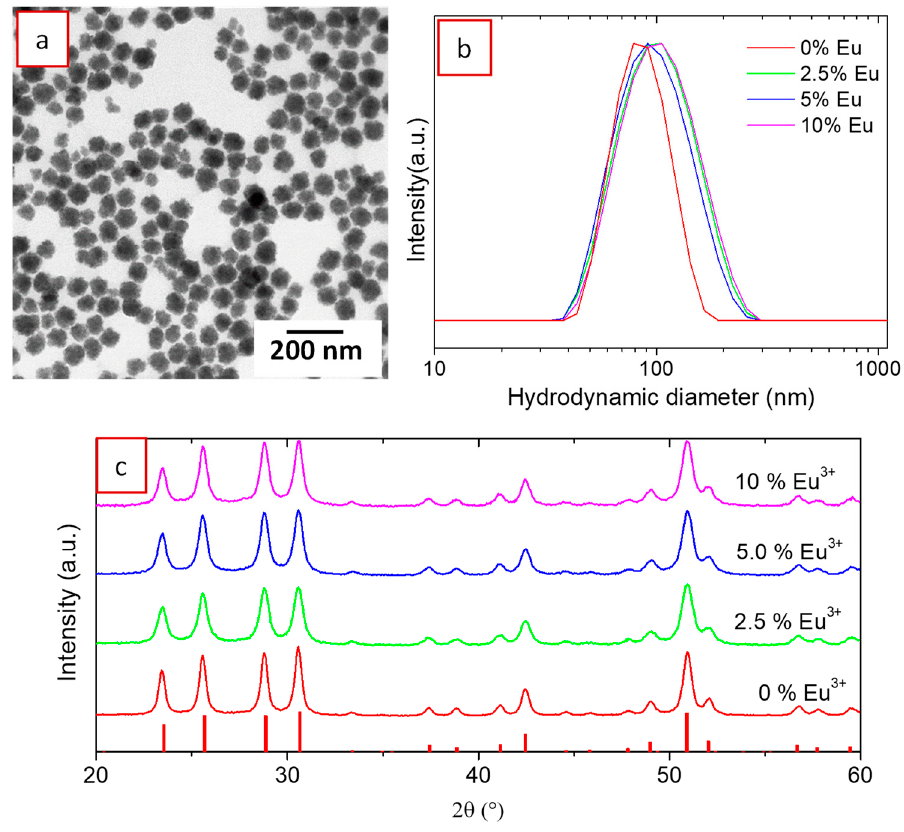
Figure 5. ( a ) TEM micrograph of 10% Eu 3 + doped (H 3 O)Lu 3 F 10 nanoparticles; ( b ) DLS curve of (H 3 O)Lu 3 F 10 nanoparticles undoped and doped with 2.5%, 5%, and 10 mol% Eu 3 + ; ( c ) corresponding XRD patterns. Ticks at the bottom of (c) correspond to cubic (H 3 O)Lu 3 F 10 (PDF 04-016-7065).